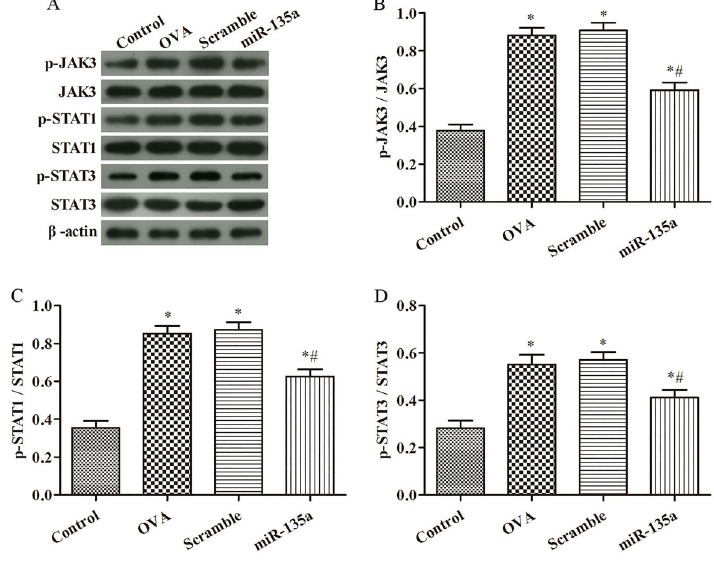
Figure 4. Western blot analysis of JAK/STAT signaling pathway-related protein expression in mouse lung tissue. A , Protein band diagram; B , p-JAK3/JAK3; C , p-STAT1/STAT1; D , p-STAT3/STAT3. Data are reported as means ± SD. *P o 0.05 compared to the control group; # P o 0.05 compared to the ovalbumin (OVA) group (ANOVA).